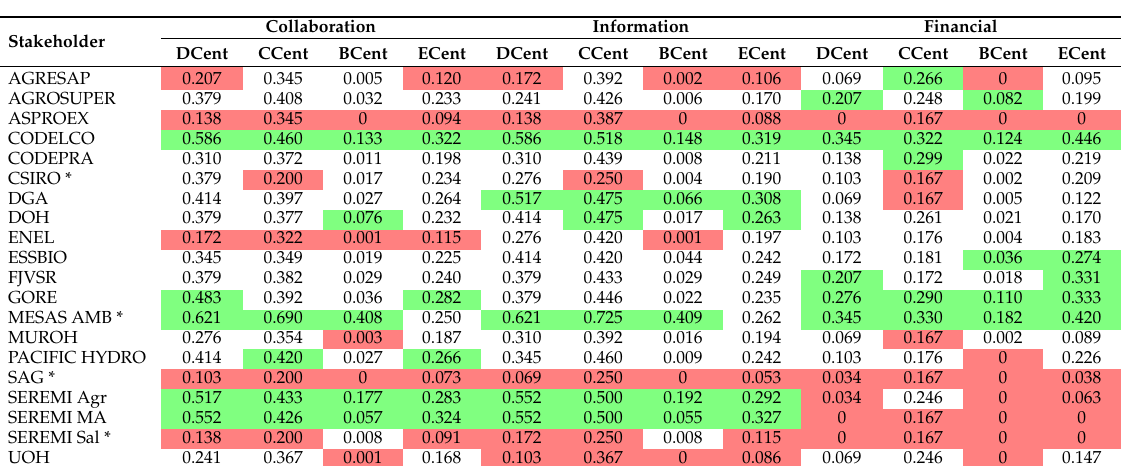
Table 2. Centrality metrics for collaboration ties, information flows and financial exchanges networks for stakeholders in the RRB. DCent, Degree Centrality; CCent, Closeness Centrality; BCent, Betweenness Centrality; ECent, Eigenvector Centrality. Red coloured cells represent five bottom-ranked metric values, while green-coloured cells represent five top-ranked metric